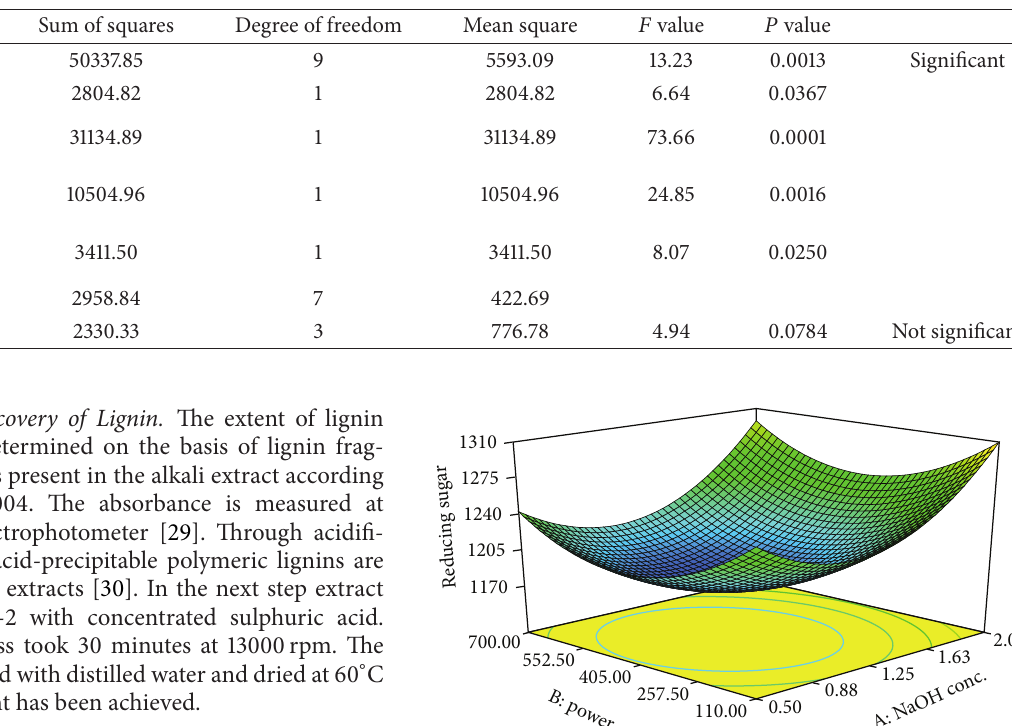
Table 2: ANOVA of the quadratic model microwave and NaOH pretreatment and its influential factors.